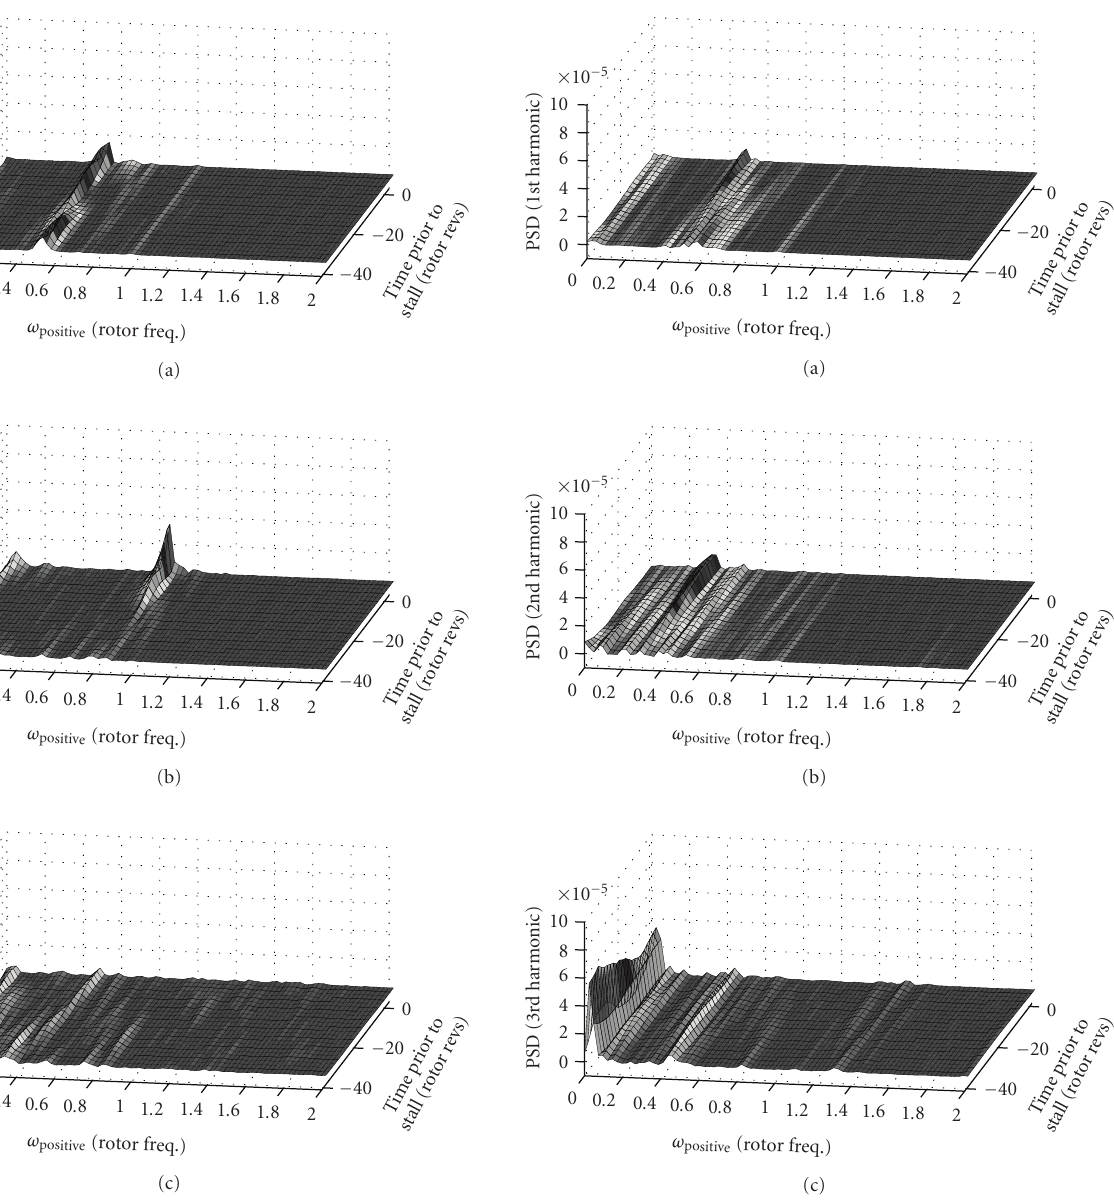
Figure 18: PSD of first three spatial harmonics of measured prestall disturbance with first harmonic control (positive rotating frequen- cies).